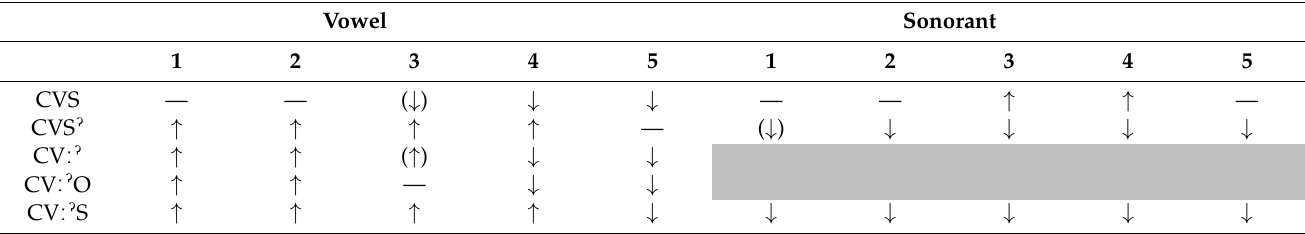
Table 6. F0 differences from the overall F0 average per word type. ↑ indicates that the average F0 for that interval is significantly higher than the overall average F0 of that word type. ↓ indicates that the average F0 for that interval is significantly lower than the overall average F0 of that word type. Arrows in parentheses indicate marginally significant effects (significant at the 0.05 level), and dashes indicate no significant difference. For CV